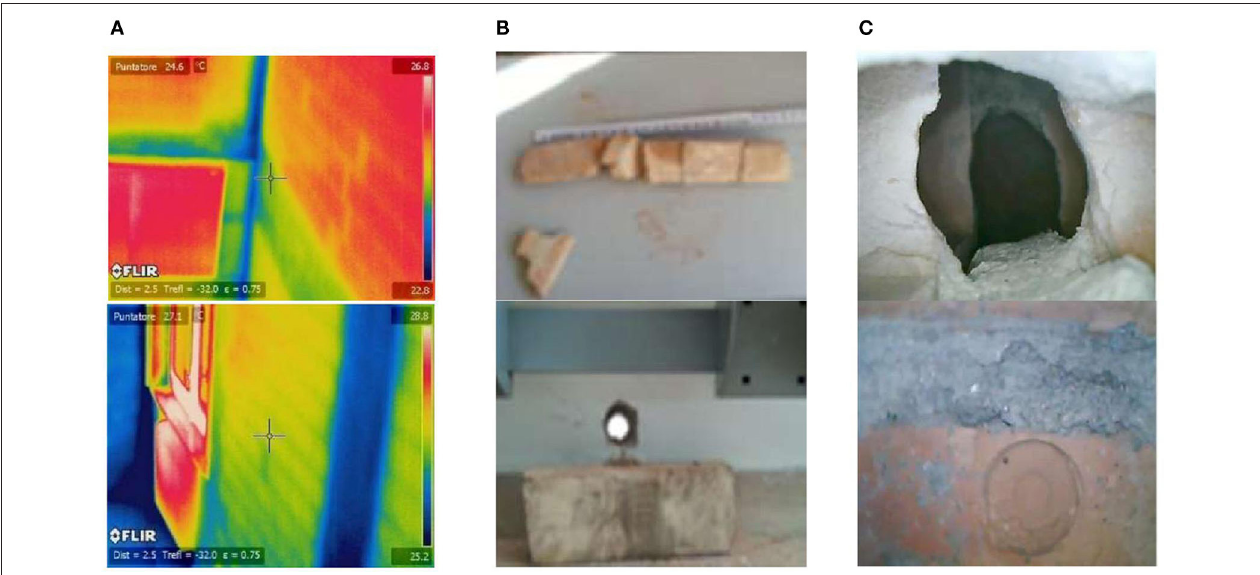
FIGURE 3 | Infill wall identification: (A) Thermographic test, (B) essay, (C) endoscopic test.